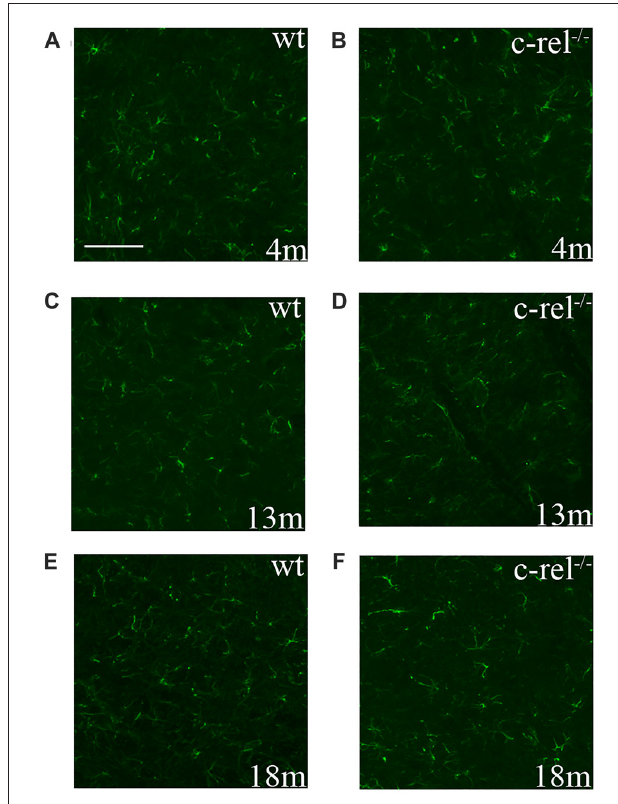
FIGURE 5 | GFAP immunoreactivity in c-rel − / − and wt mice. Pictures of SN sections from 4- (A,B) , 13- (C,D) and 18-month-old (E,F) animals illustrating GFAP astroglial immunostaining. No evident changes in astroglial activation were found in c-rel − / − mice (B,D,F) compared to age-matched wt (A,C,E) . Immunofluorescence images are representative of five sections from each animal ( n = 3 animals per group). Abbreviations: GFAP, glial fibrillary acidic protein; SN, substantia nigra. Scale bar: in (A) = 100 µ m for (A–F)